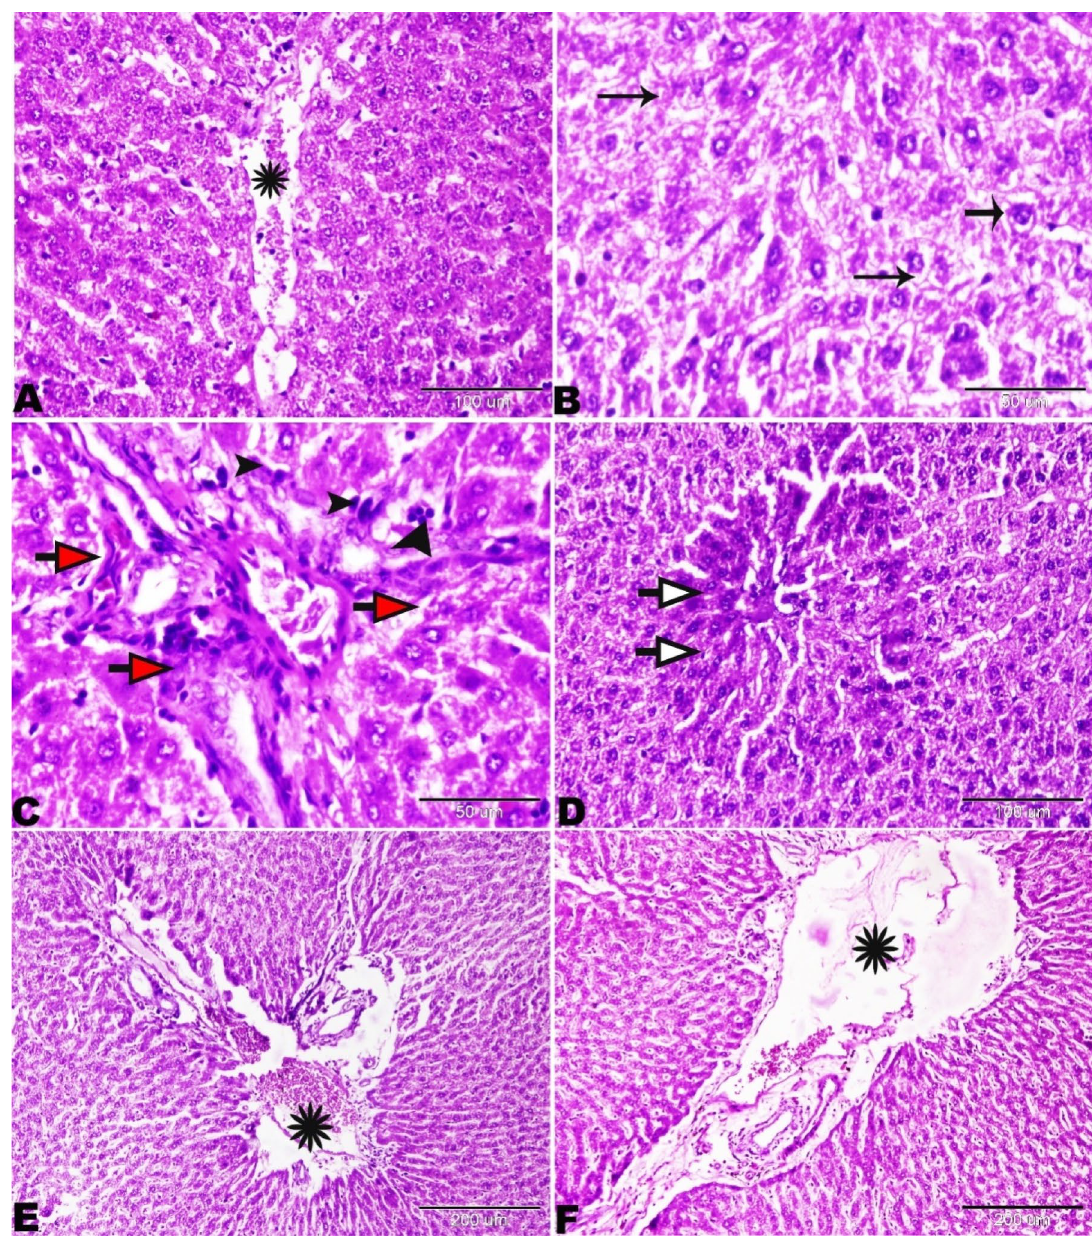
Figure 12. Photomicrograph of the rat livers of Group V (basal diet 70% + cheese containing S . thermophilus S 3855 30%). ( A ) Dilated central vein engorged with blood (star). ( B ) Vacuolation in hepatocytes (arrows). ( C ) Focal areas of fibroses (red arrows), mononuclear lymphocytic infiltration (black arrowheads). ( D ) Focal areas of coagulative necrosis (white arrows). ( E ) Wide portal areas showing extensively wide portal veins filled with blood (stars). ( F ) Severe periportal edema (star). H&E stain, the bar size was indicated under